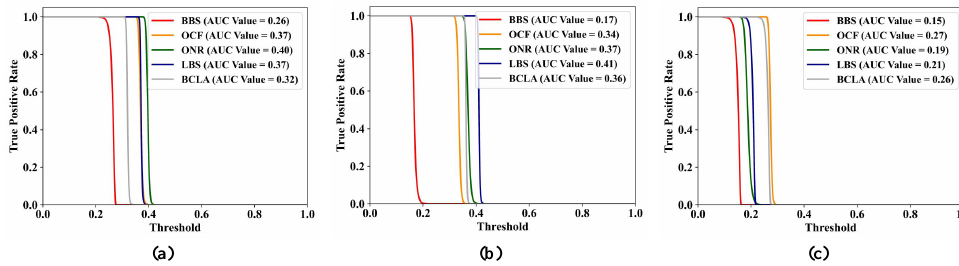
Figure 20. The ROC of ( P F , Threshold ) for the UTD results on the sea water data set with different band selection methods. The number of selected bands is ( a ) 17, ( b ) 27, ( c )